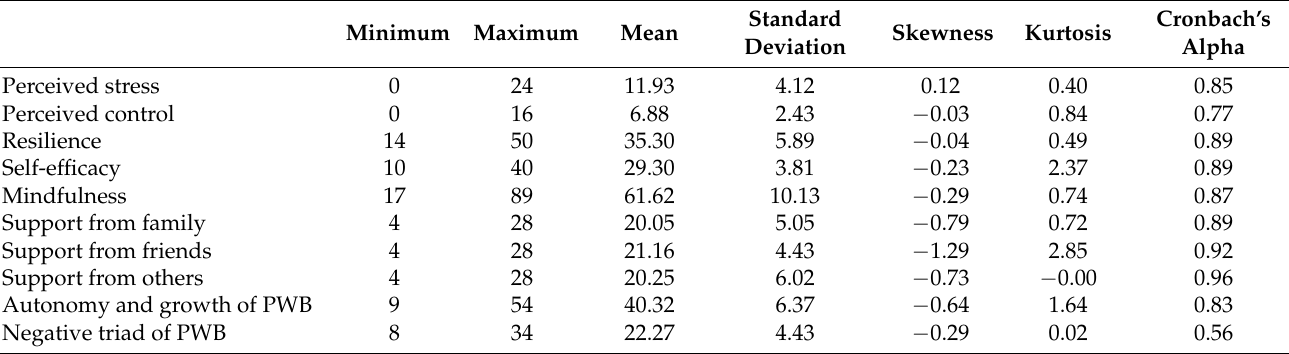
Table 3. Description of study variables for Singaporean sample (n =